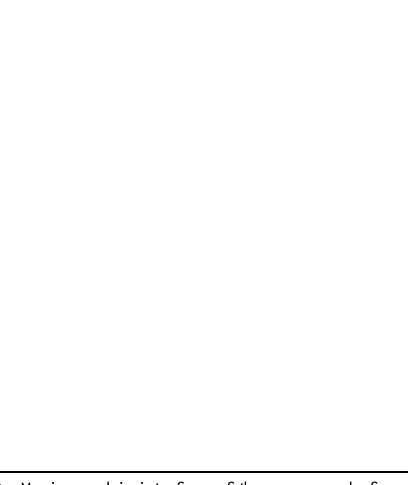
Figure 1 - Opening page of the program, with